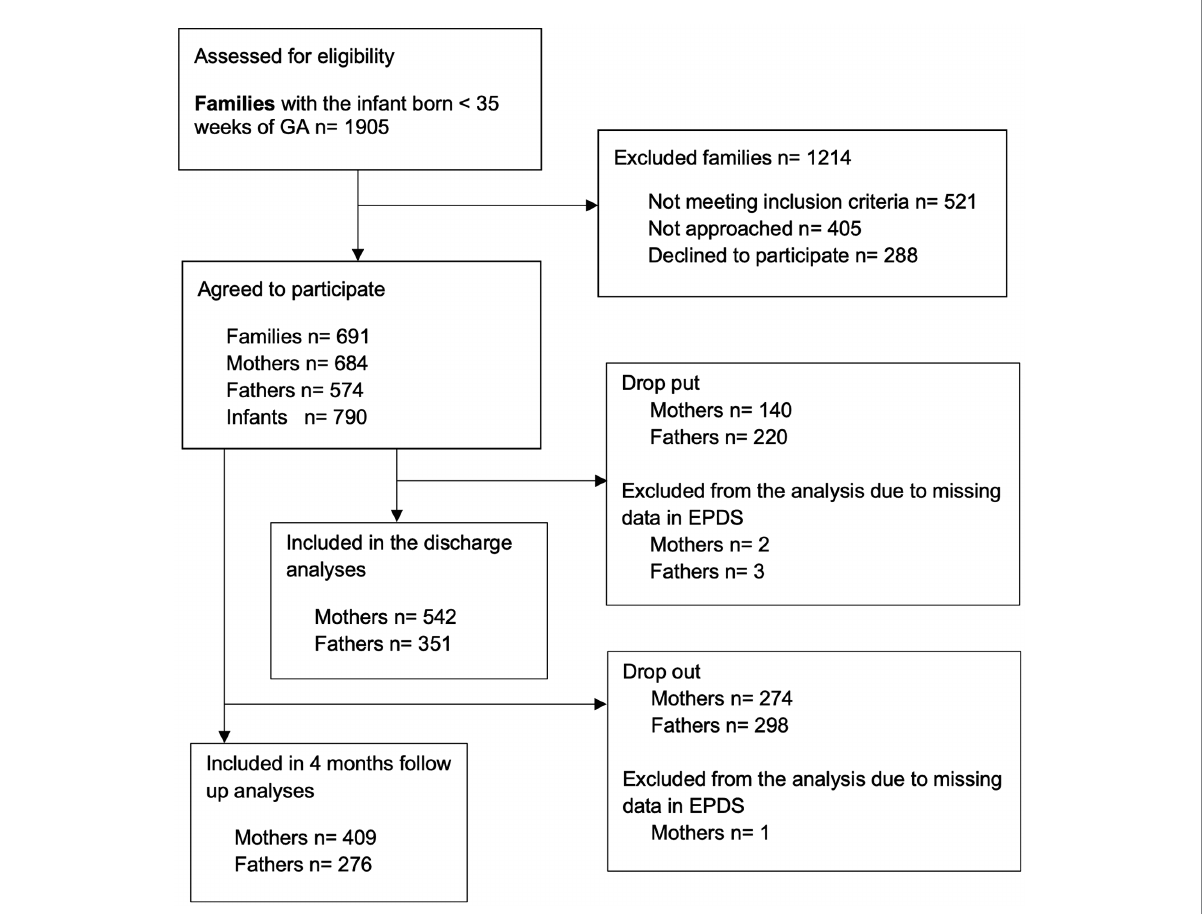
FIGURE 1 Flowchart on eligible families, those approached and those who agreed to